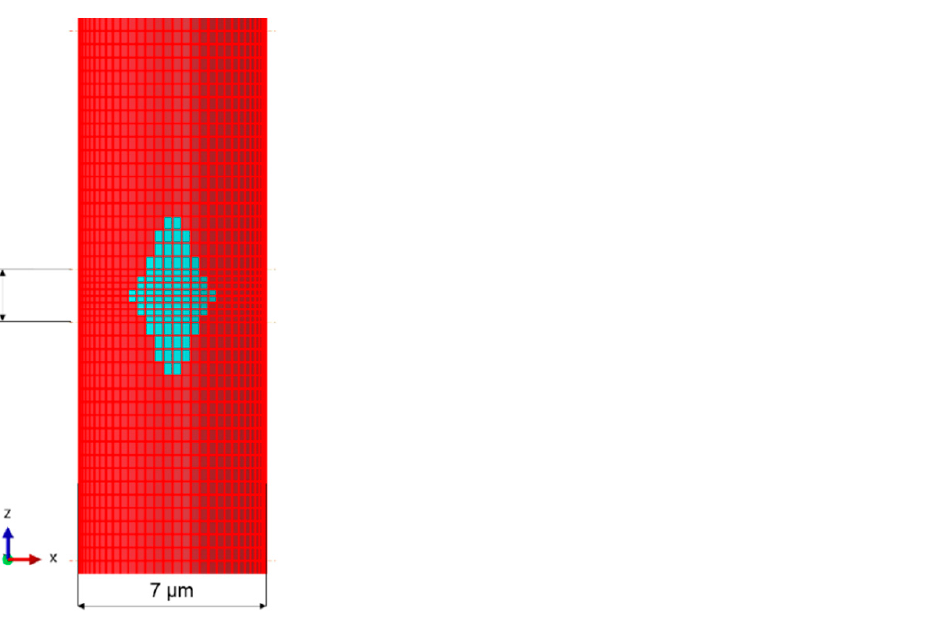
Figure 3. Depiction of the investigated debonding scenario of a cluster defect in the fiber − matrix interface with shown center section of 2 µ m (only the C-fiber is shown).